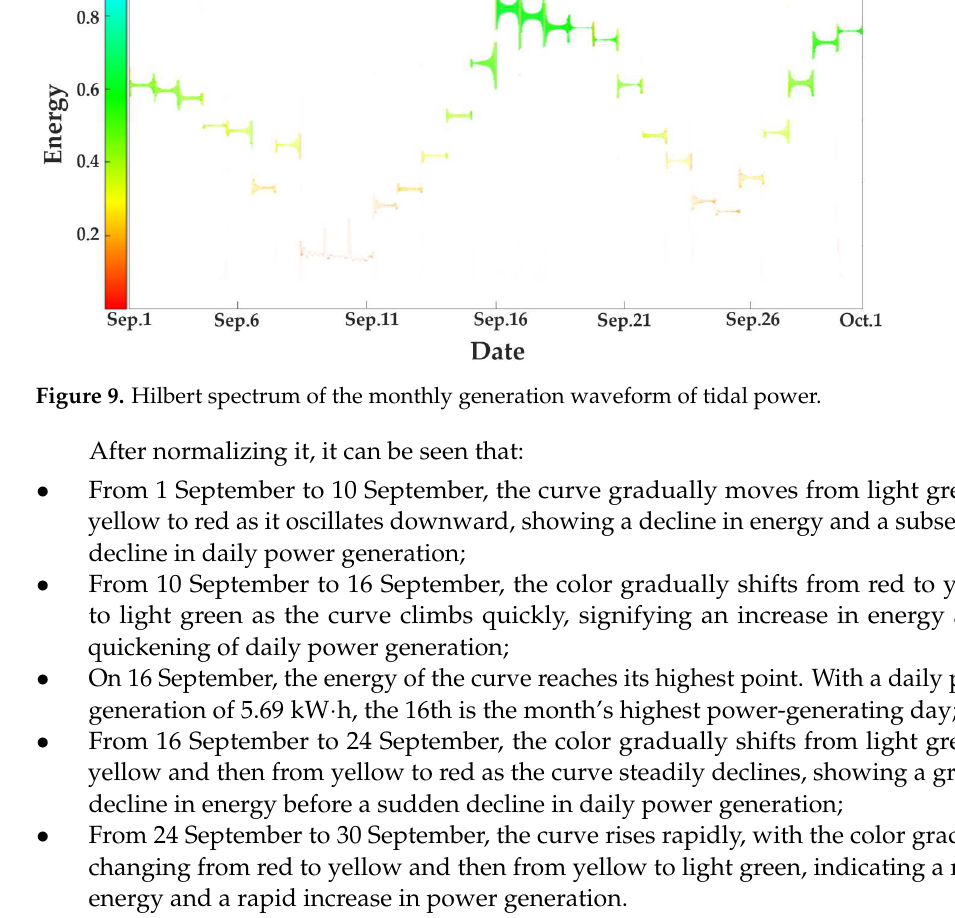
Figure 8. EMD decomposition of the monthly generation waveform of tidal power.